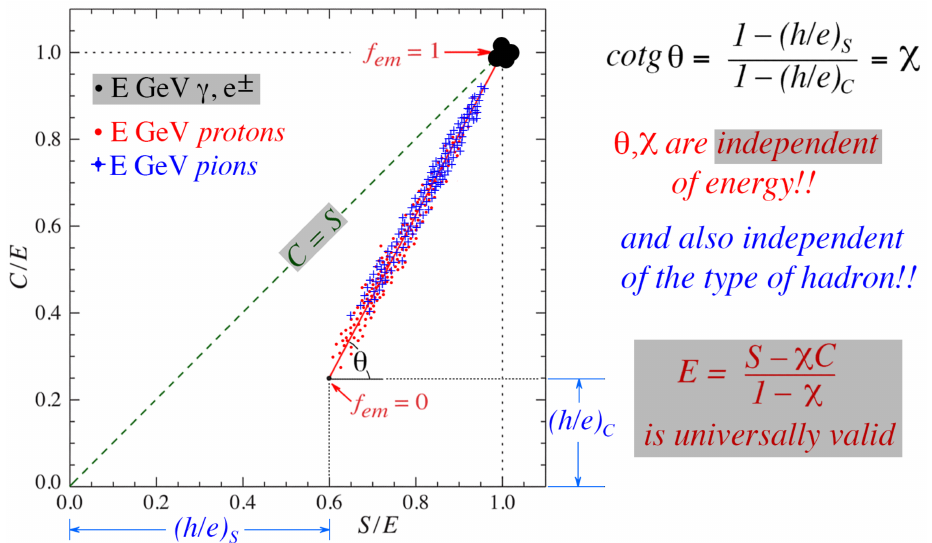
Figure 9. The dual-readout method is independent of the energy and the type of hadron. It also works well for